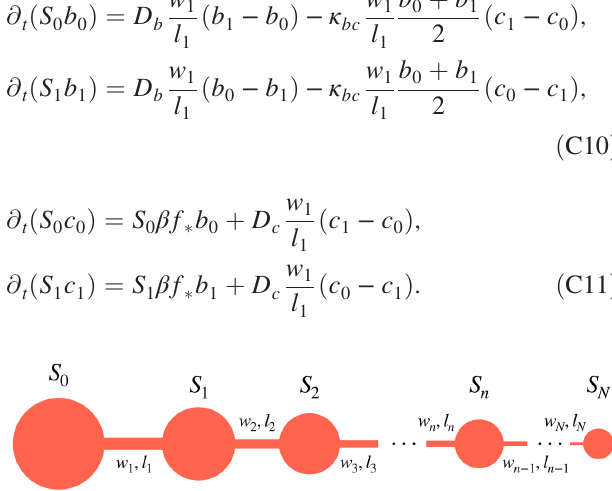
FIG. 8. A simple multiscale geometry that can be used to demonstrate the amplification of bacterial collapse and fractal